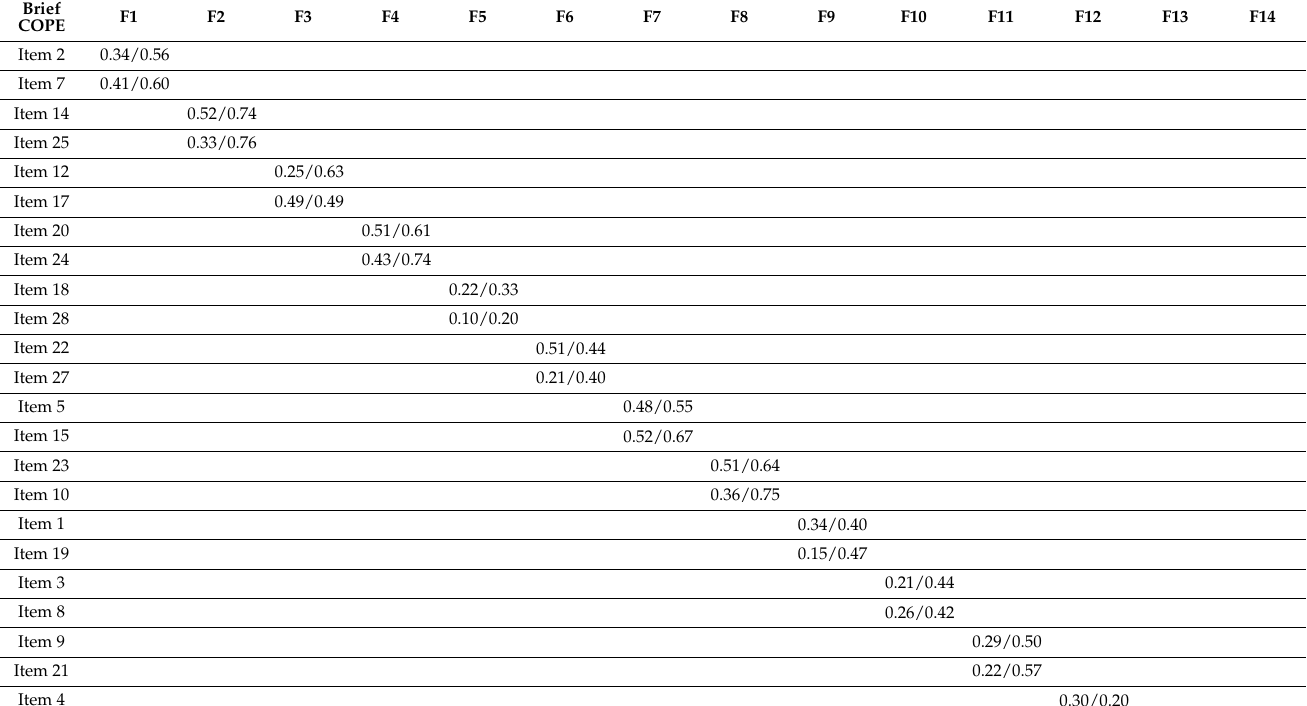
Table 2. Standardized factor loadings of the 14-factor model of Brief COPE (at-risk sample/community sample). Brief